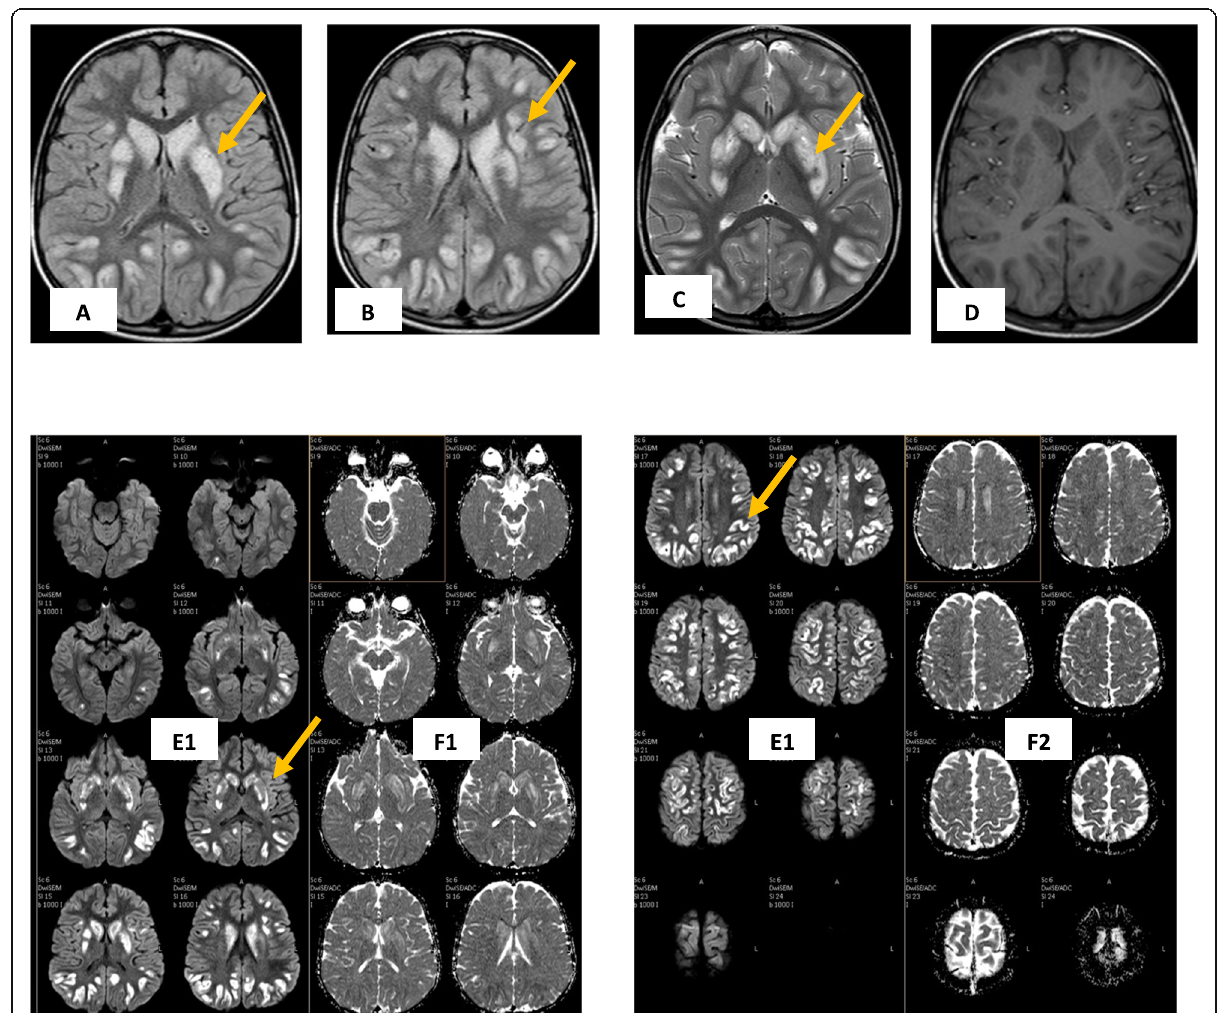
Fig. 6 3-years-old boy with Leigh syndrome . Different sequences MRI revealed high T2WI and FLAIR signal at both BG, thalami and the white matter. DWI showed restricted diffusion in acute phase (yellow